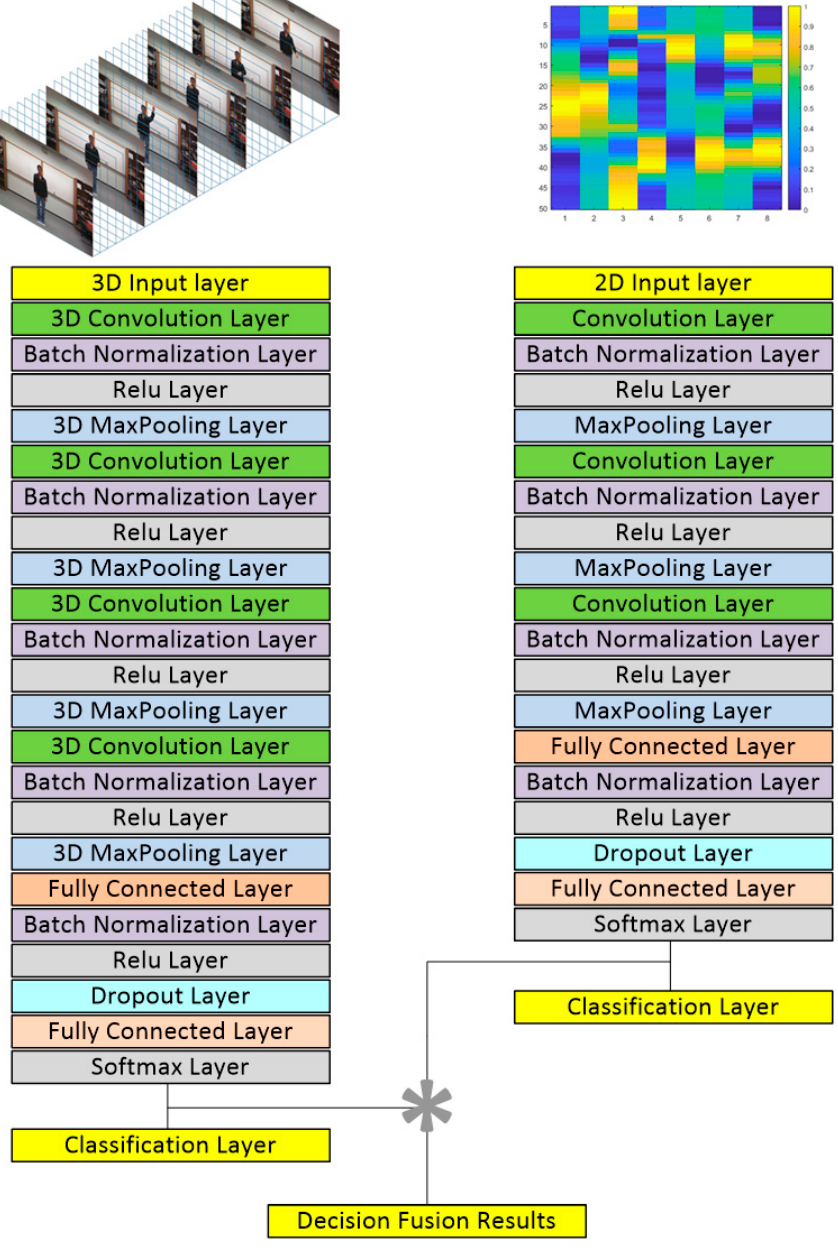
Figure3. Figure 3. Network architecture used for the decision-level fusion of video and inertial sensing modalities. Table 2. Architecture of the 3D convolutional neural network.